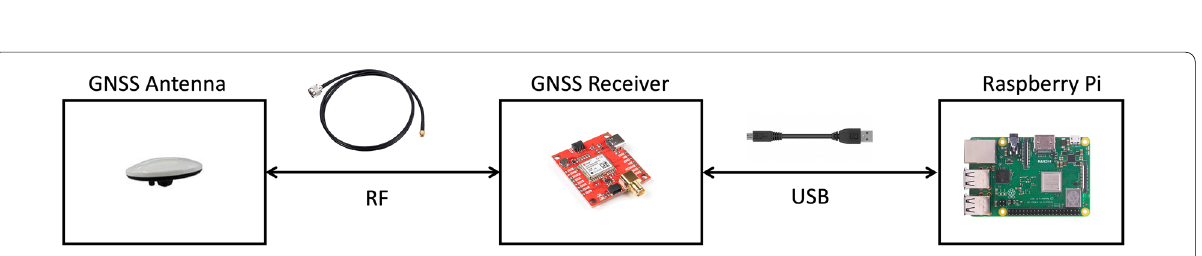
Fig. 2 Diagram illustrating the main components and connections of a ScintPi